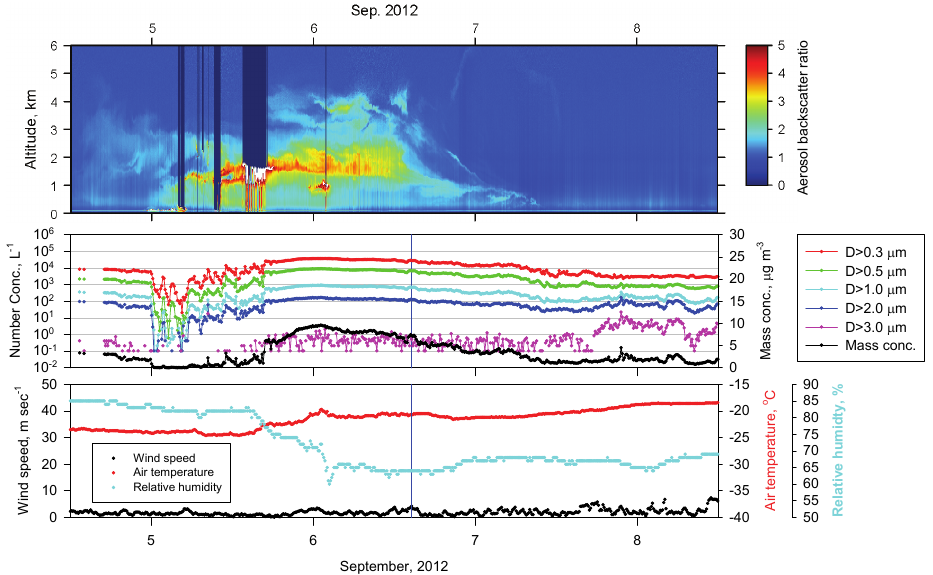
Fig. 4 Fig. 4. Short-term variations of the aerosol backscatter ratio, aerosol number concentration, mass concentration, wind speed, air temperature,